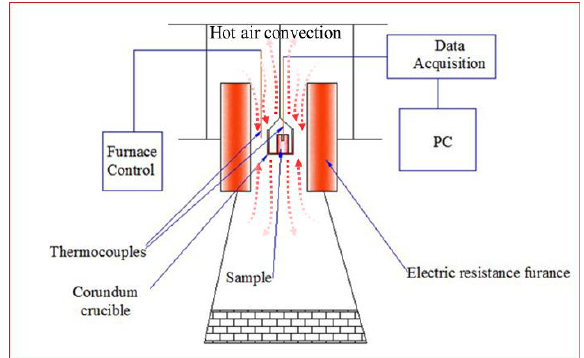
Figure 1. The schematic diagram of ignition temperature test device. The ignition temperature is identified by the sharp increase of the sample temperature measured by a K-type thermocouple placed in a small hole drilled into the center of the sample.